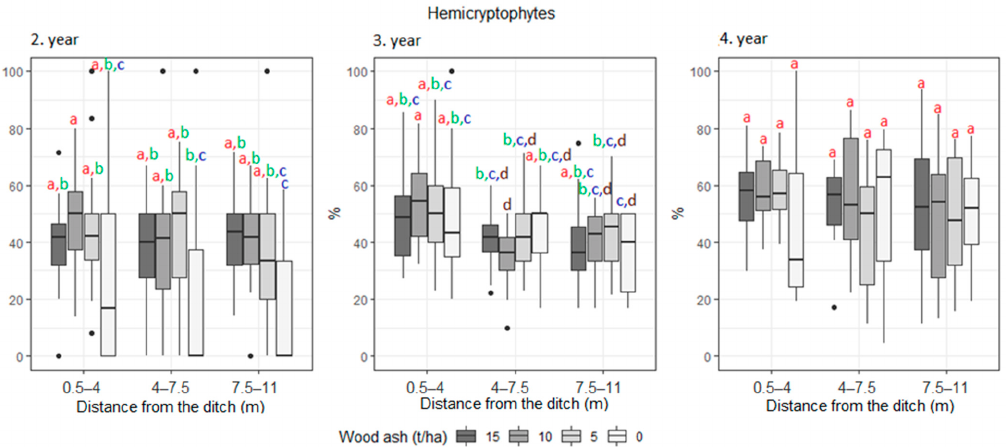
Figure A2. Relative cover of plants with hemicryptophyte growth form from the total vegetation cover, depending on the distance from the drainage ditch and the dose of wood-ash fertiliser. Different letters (a, b, c, d) indicate significant differences between groups, p < 0.05 according to the Tukey HSD test.